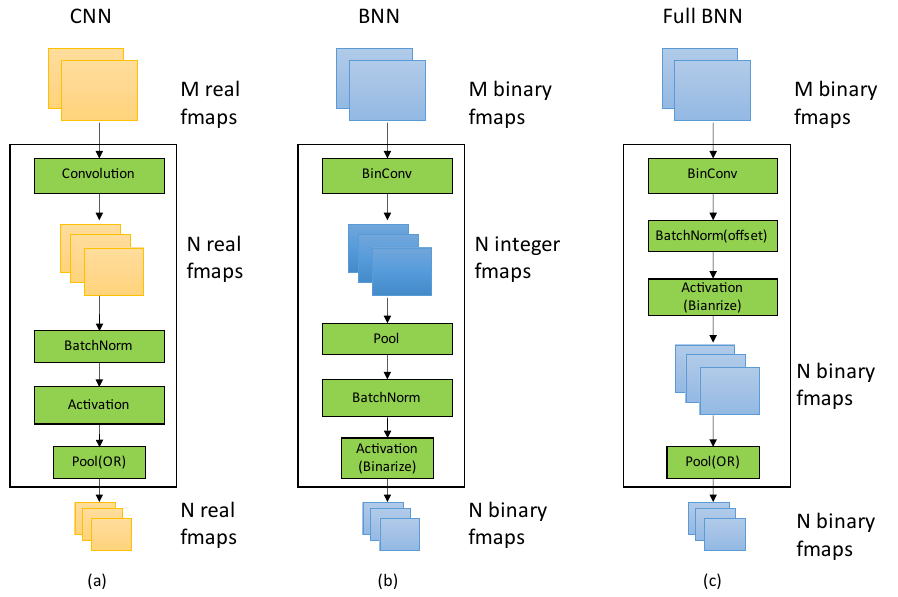
Figure 9. Comparison of three models: ( a ) traditional CNN; ( b ) BinaryNet [6]; ( c ) our full BNN. As shown in Figure 9c, the intermediate results after binary convolution, batch nor- malization, and activation function are 1 bit output feature maps. It can be seen that there are no intermediate results of real or integer values within layers and between each